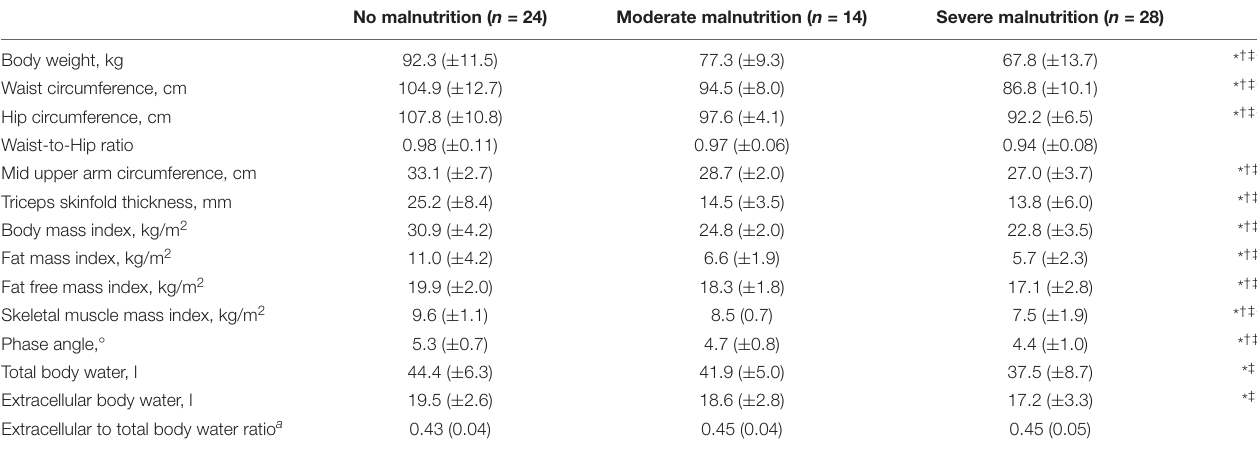
TABLE 3 | Comparison of anthropometric parameters and body composition in patients with chronic pancreatitis stratified by nutritional status. No malnutrition ( n = 24) Moderate malnutrition ( n = 14) Severe malnutrition ( n = 28)